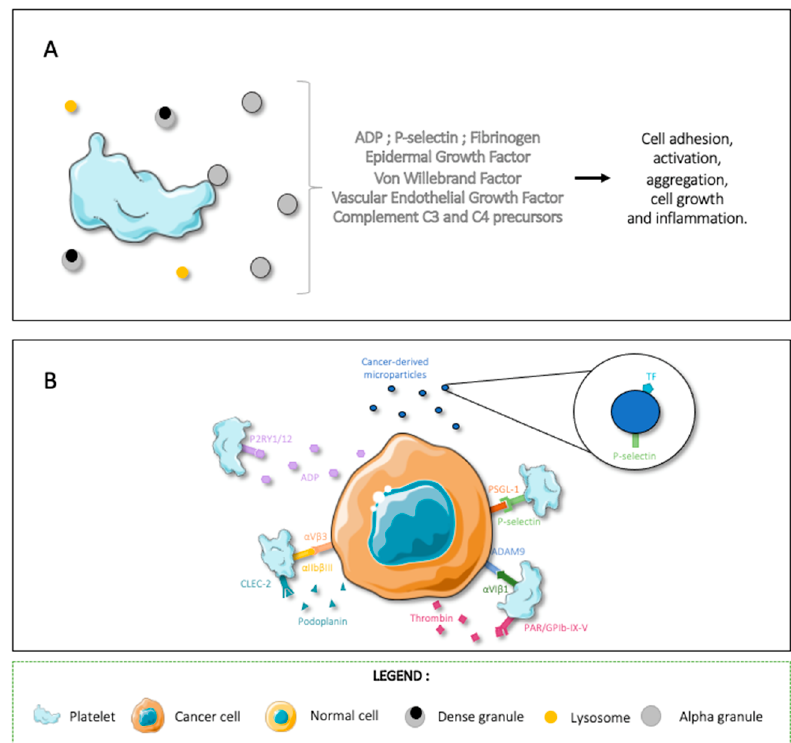
Figure 1. Schematic representation showing how the interaction of platelets with cancer cells can induce cancer-associated thrombosis. ( A ) Platelets have three distinct types of granules: alpha,